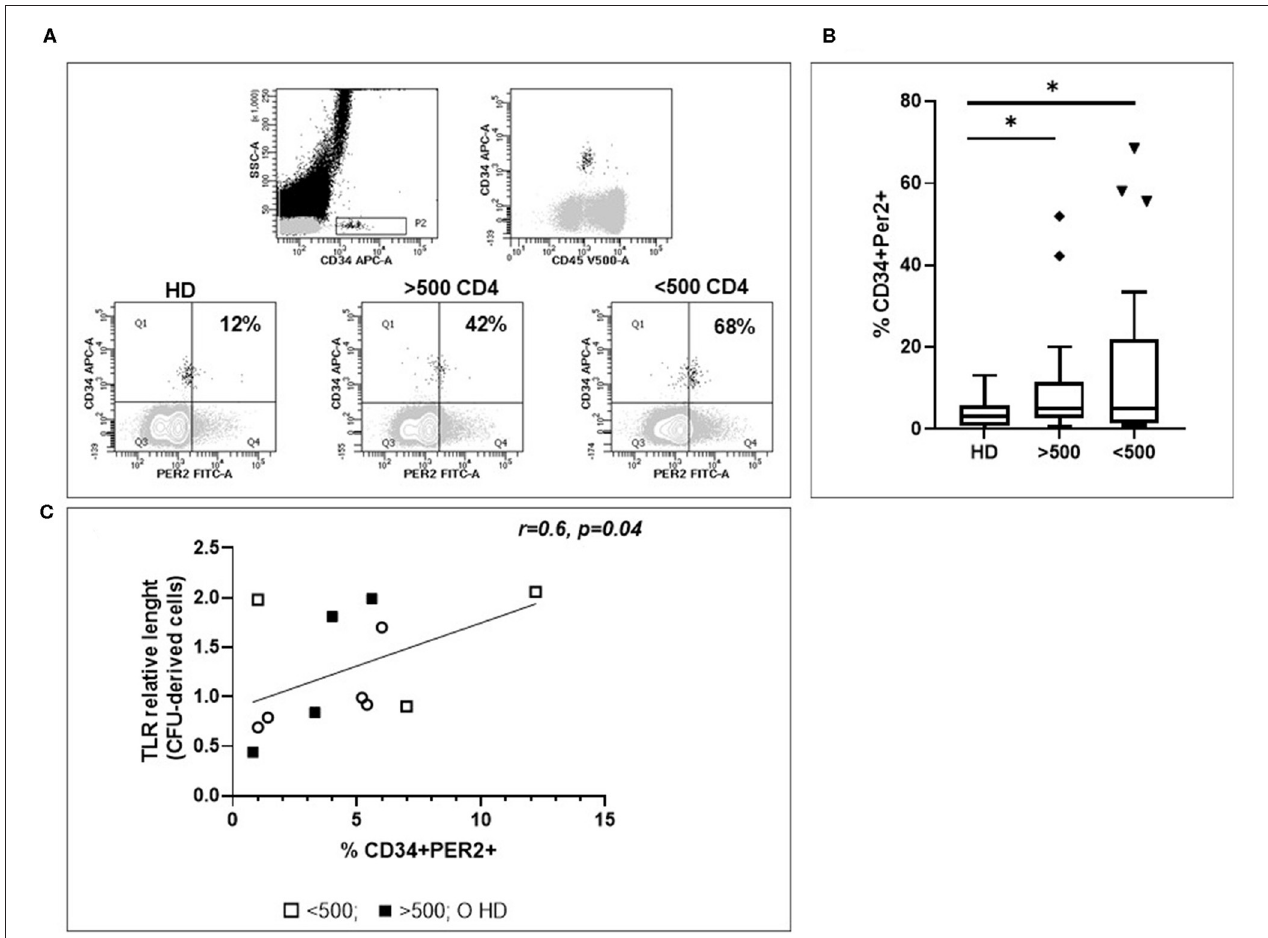
FIGURE 2 | Evaluation of Per2 expression in circulating HPC. (A) Representative flow cytometry contour plots of CD34 + CD45 + /low cells from whole blood of HIV + patients. In the square the percentage of CD34 + Per2 + cells is shown. To set Per-2 positive/negative gate, we used a mix of antibodies containing CD34–APC and the secondary antibody Alexa 488 without Per2 primary antibody. (B) Histograms show the median and range percentage of CD34 + Per2 + cells of HD and HIV-infected patients. Mann–Whitney test, * p < 0.05; HD, healthy donors ( n = 32), HIV + patients with CD4T cells count < 500 ( n = 27), HIV + patients with CD4T cells count > 500 ( n = 26). (C) Linear regression analysis between RTL of CFC derived cells and % CD34 + Per2 + cells ( r = 0.6, p =